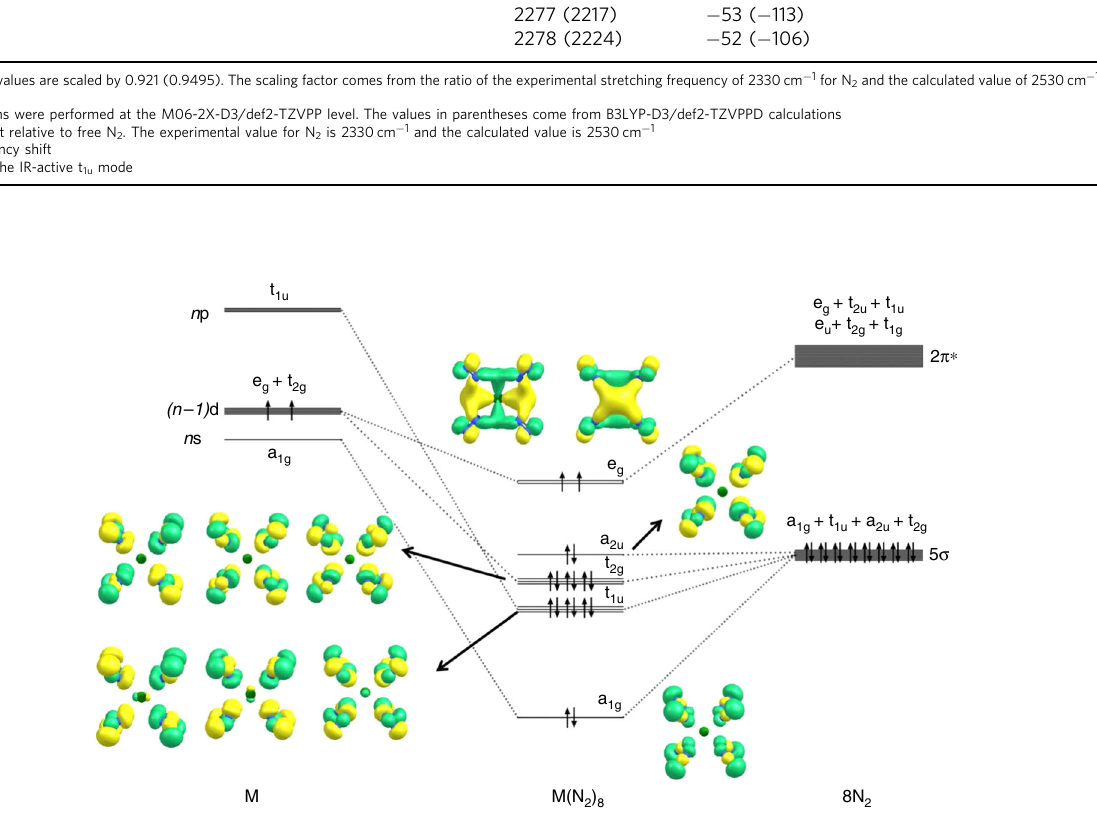
Fig. 3 Orbital correlation diagram. Orbital correlation diagram of the spd valence orbitals of an atom M with the con fi guration ( n − 1)d 2 ( n )s 0 ( n )p 0 in an octa-coordinated cubic ( O h ) fi eld of eight N 2 ligands and occupied valence orbitals of Ca(N 2 ) 8 . Only the occupied valence orbitals that are relevant for